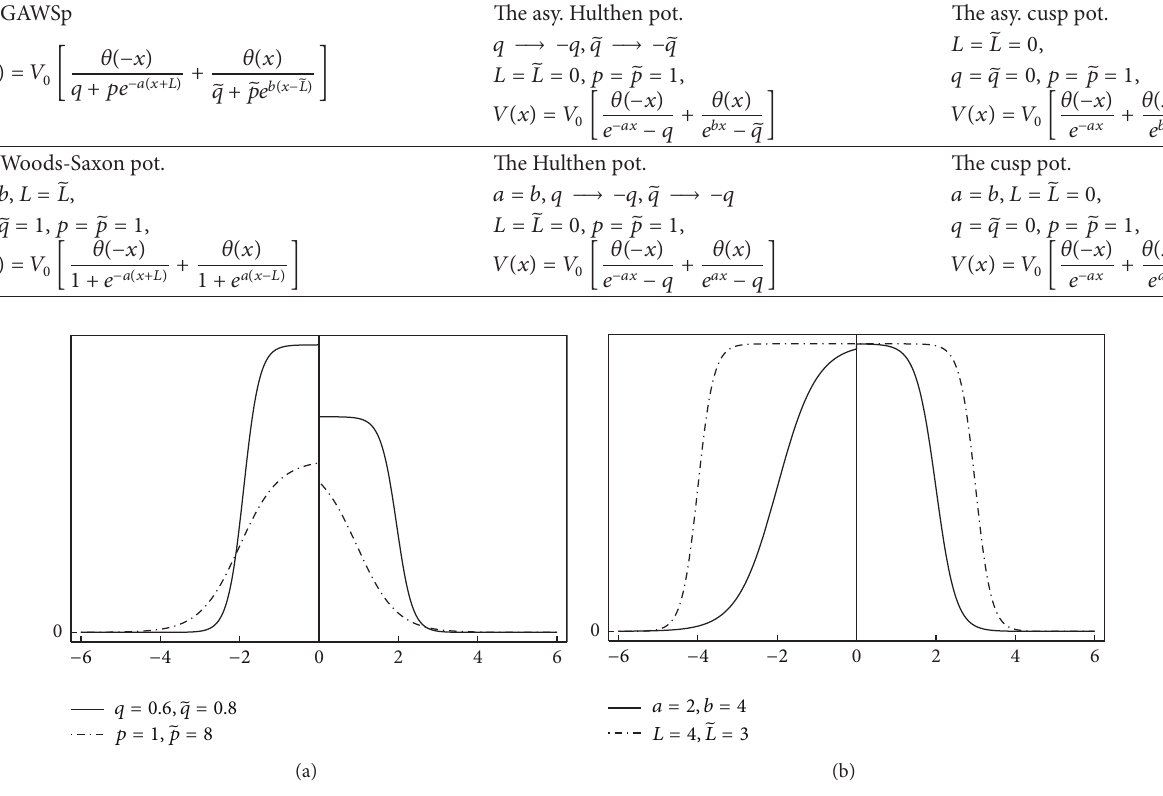
The Hulthen pot. The cusp pot.